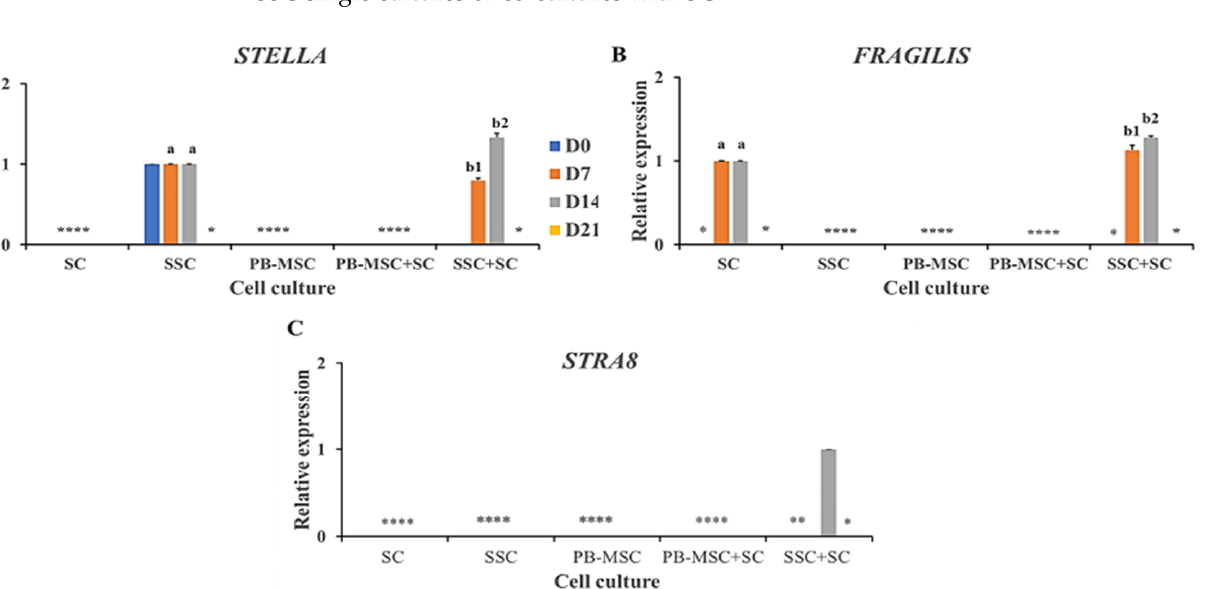
Figure 5. Expression of GC markers STELLA , FRAGILIS and STRA8 in single cultures and co-cul- tures of bull PB-MSC, SSC with SC in 3D SACS for 21 days. ( A–C ) Higher expression of STELLA was detected on days 7 and 14 in co-cultures of SSC+SC compared to SSC. ( B ) Expression levels of FRAGILIS expression were higher ( p < 0.05) in SSC+SC co-cultures compared to SC on days 7 and 14. ( C ) STRA8 gene expression was only detected in SSC+SC co-culture on day 14. ( D ) Immunoflu- orescence associated to STELLA was observed in SSC and SSC+SC co-culture at day 14. ( E ) STRA8